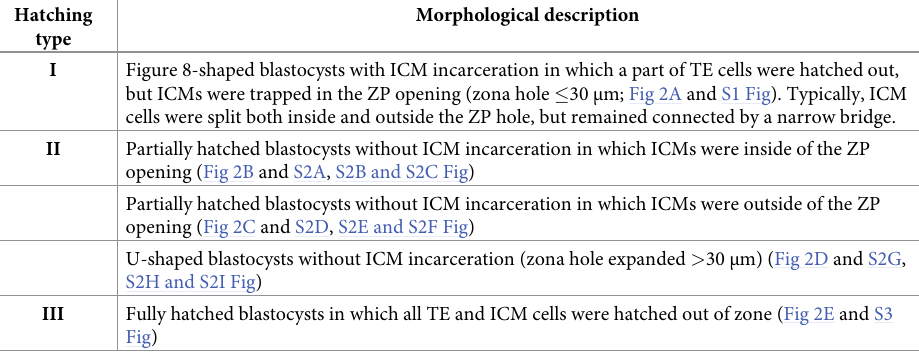
Table 1. Morphological description of three hatching types in PGD/PGS